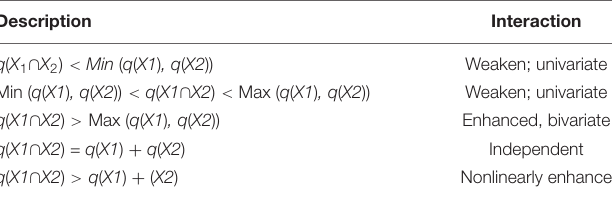
TABLE 4 | Interaction categories and interaction relationships.